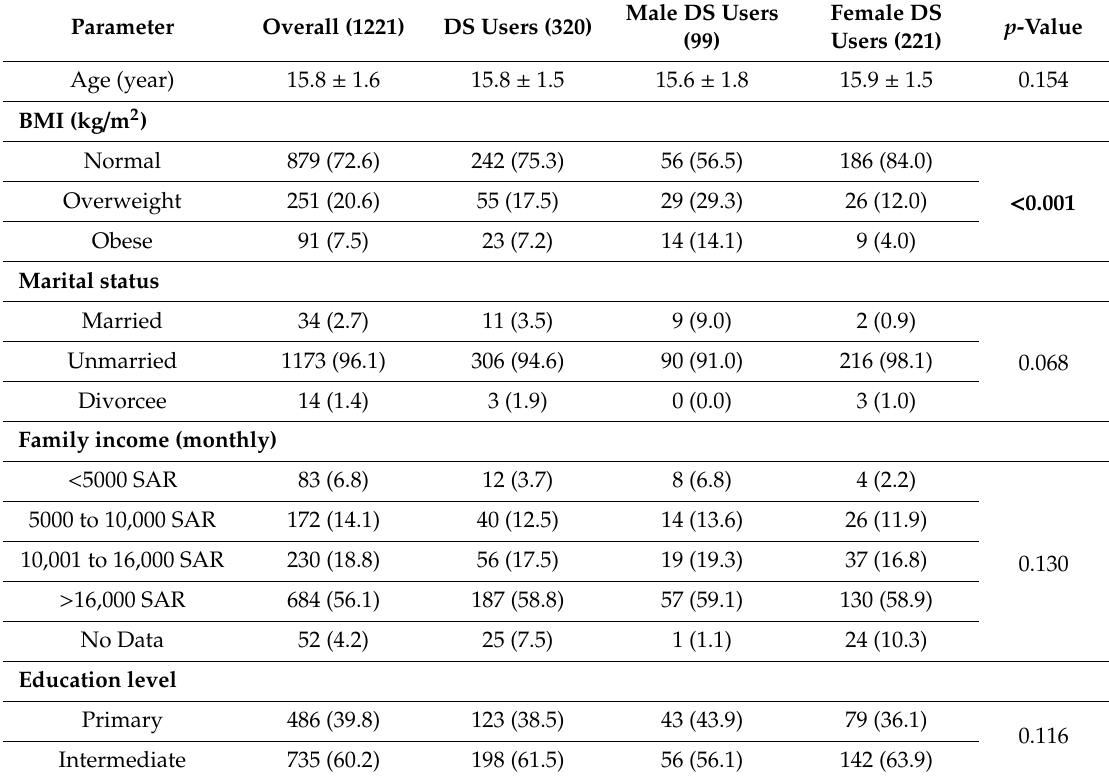
Anthropometric, sociodemographic and lifestyle characteristics among dietary supplement